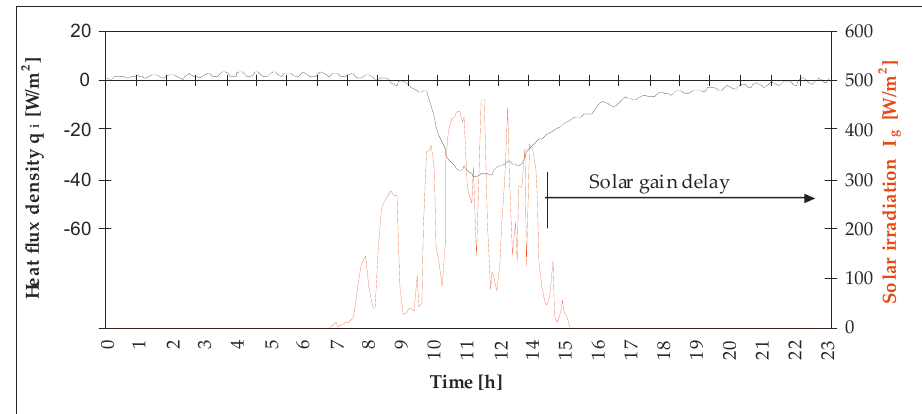
Figure 12. An example of heat flux density distribution on the IGW inner surface during a day.